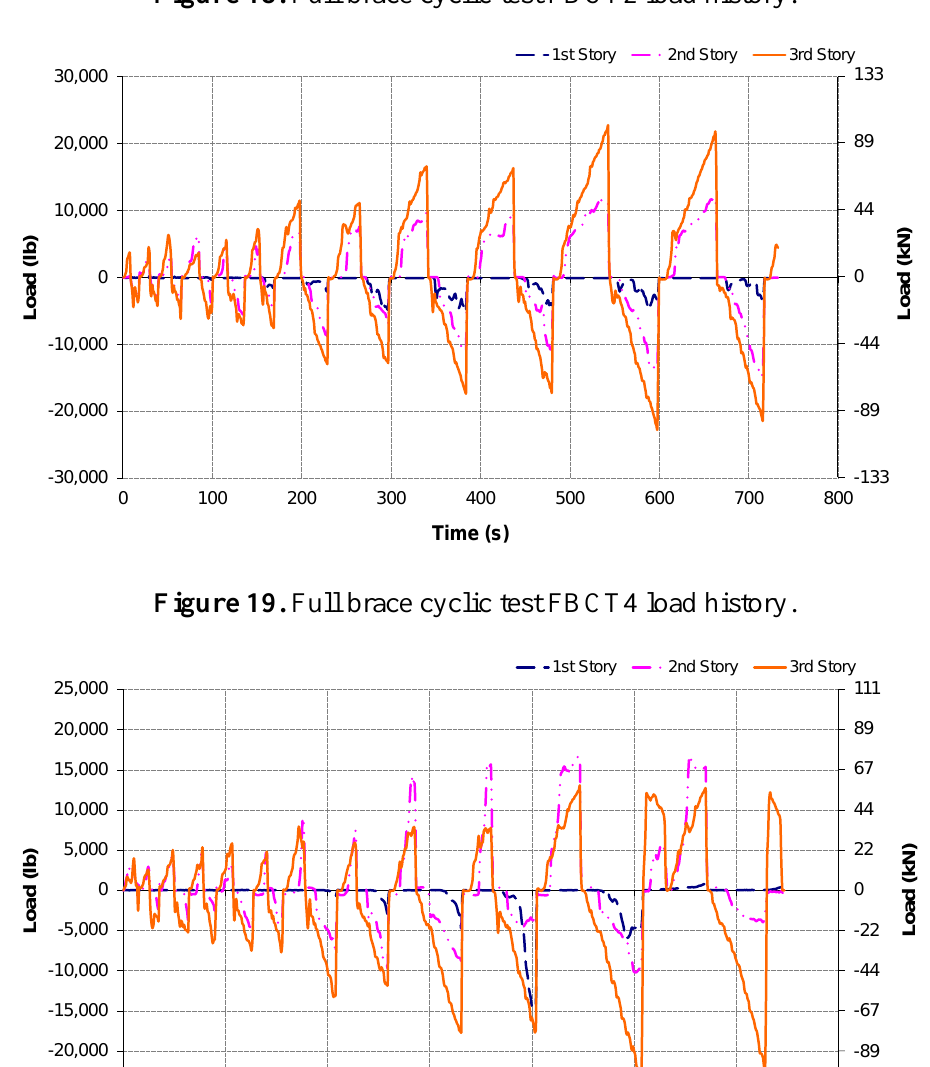
Figure 18. Full brace cyclic test FBCT2 load history.